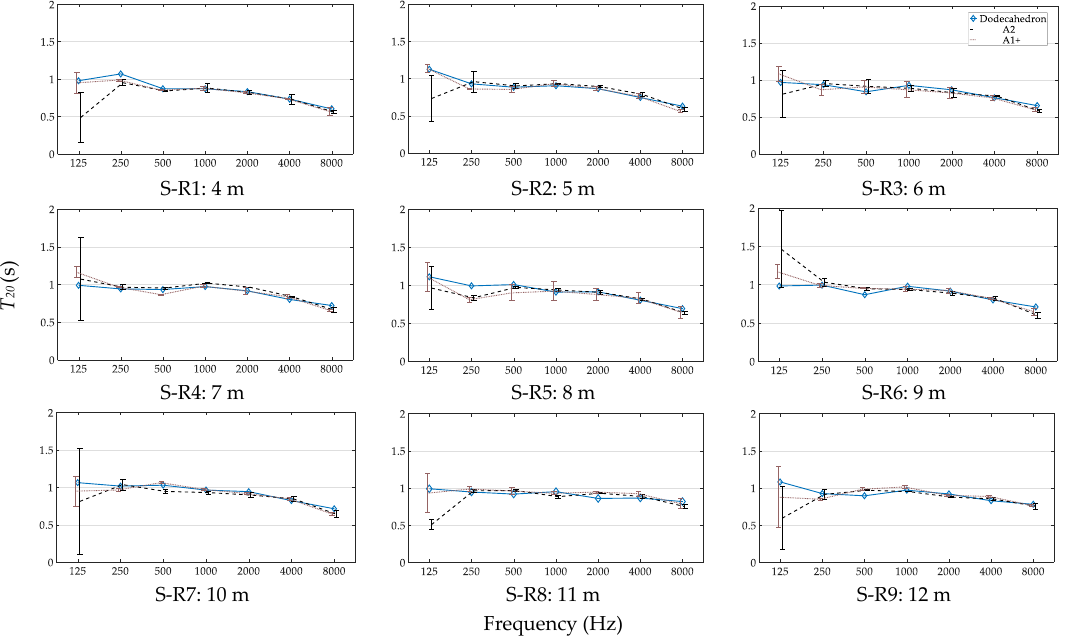
Figure 5. T 20 measurements at different source – receiver (S – R) distances. Error bars represent measured standard deviation.